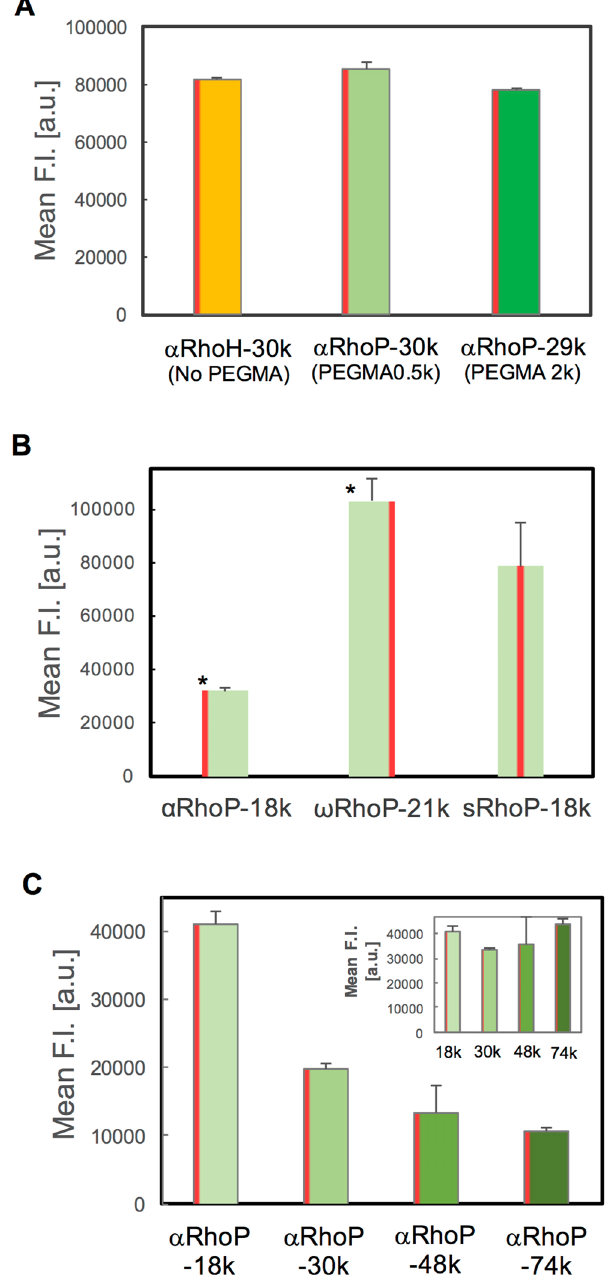
Figure 4. Fluorescence intensity of RhoP-treated HeLa cells. Each polymer was added to HeLa cells and incubated for 1 h. The fluorescent intensity was evaluated by flow cytometry and analyzed for 5,000 cells. For the analysis, the fluorescence intensity values were normalized based on the Rho substitution degree of each polymer. [RhoP] = 1.0 mg/mL ( A ) Effect of the PEG chain length. The substitution degree of PEGMA was approximately the same in all polymers; the molecular weight of PEGMA was 2,000 g/mol (left) and 500 g/mol (right). ( B ) Effect of the position of Rho. The statistical significance of the difference is indicated by * ( p < 0.01) vs sRhoP. ( C ) Effect of molecular weight of α RhoPs. (inset) Data plotted as a function of the polymer molar